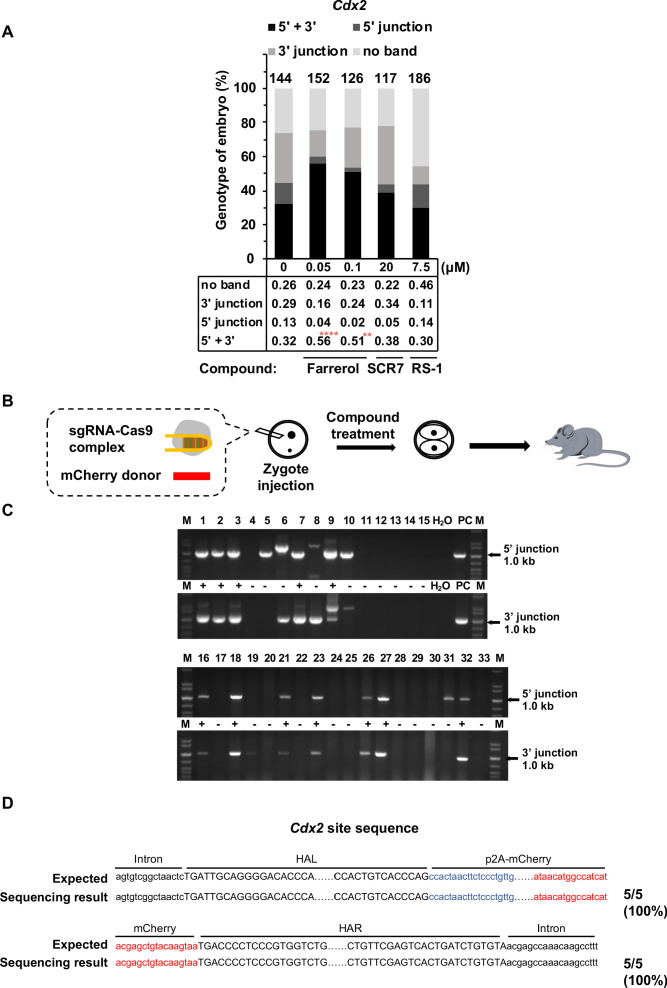
Farrerol promotes precise integration in blastocysts and founder mice.(A) Analysis of knock-in frequencies at the Cdx2 locus in mouse blastocysts treated with indicated doses of molecules by genotyping analysis. The blastocysts were lysed for genomic DNA extraction, then the 5’ and 3’ junction at the Cdx2 locus were amplified for Sanger sequencing. (B) Experimental scheme for targeted Cdx2-p2A-mCherry knock-in founder mouse. (C) Genotyping analysis of gene-targeting mice. Genomic DNA were prepared from mouse tail tips, then the 5’ and 3’ junction at the Cdx2 locus were amplified. H2O is set as negative control. For positive control (PC), the gDNA of mouse blastocysts which has been successfully knocked-in at Cdx2 site using the same sgRNA and donor, was used as the template for PCR. (D) Precise in-frame integration was further confirmed by Sanger sequencing in the five gene-targeting mice in farrerol treatment group. HAL stands for the left homologous arm and HAR stands for the right homologous arm. **p<0.01, ****p<0.0001, χ2-test.